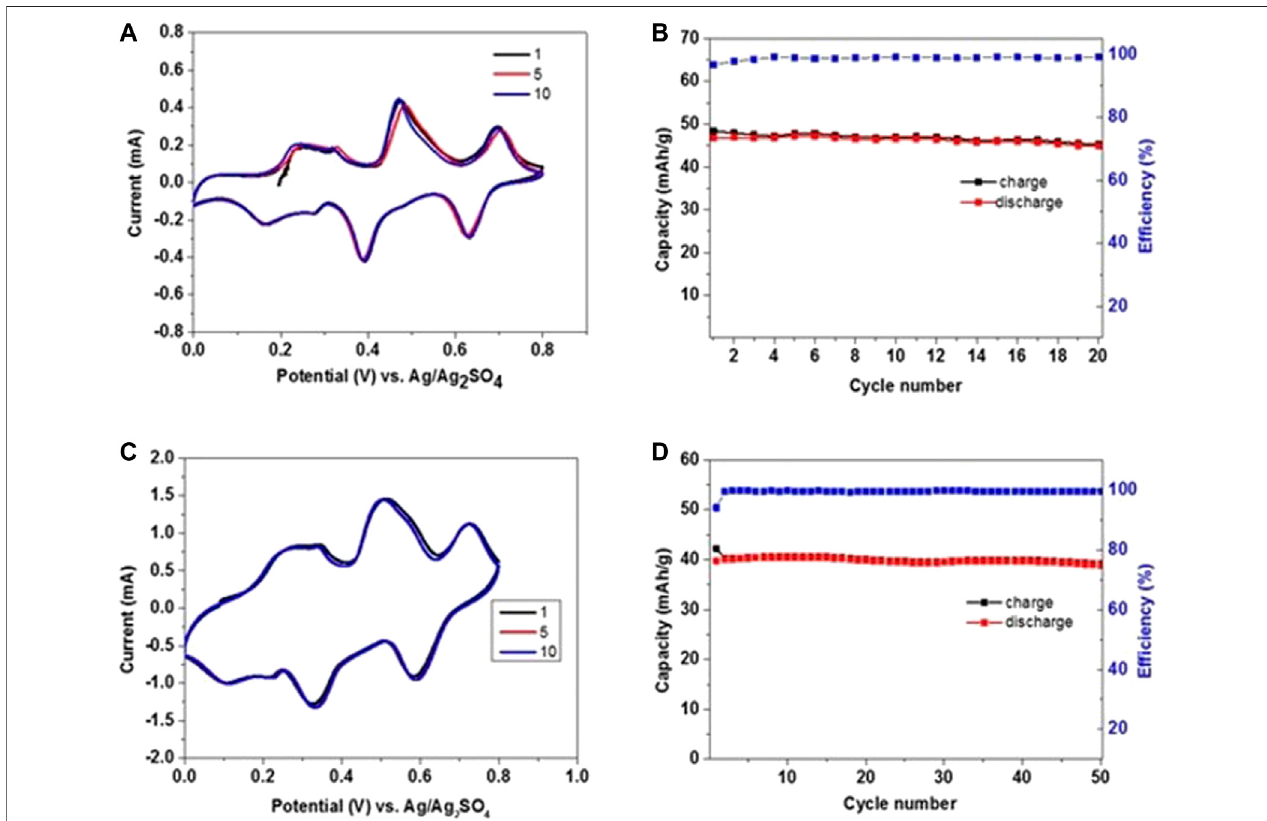
FIGURE 5 | CVs of NMO electrodes in saturated NaClO 4 electrolyte solution. The counter electrode comprised activated carbon and the reference electrode was Ag/Ag 2 SO 4 (A) A scan rate of 0.1 mV/s for 20 cycles in the voltage window of 0 – 0.8 V vs. Ag/Ag 2 SO 4 and (B) corresponding charge and discharge values during repeatedanodicandcathodiccycling. (C) Thescanrateischangedto0.5 mV/safter20cycleswithinthesamevoltagerange. (D) Chargeanddischargevaluesupto50 cycles at 0.5 mV/s.